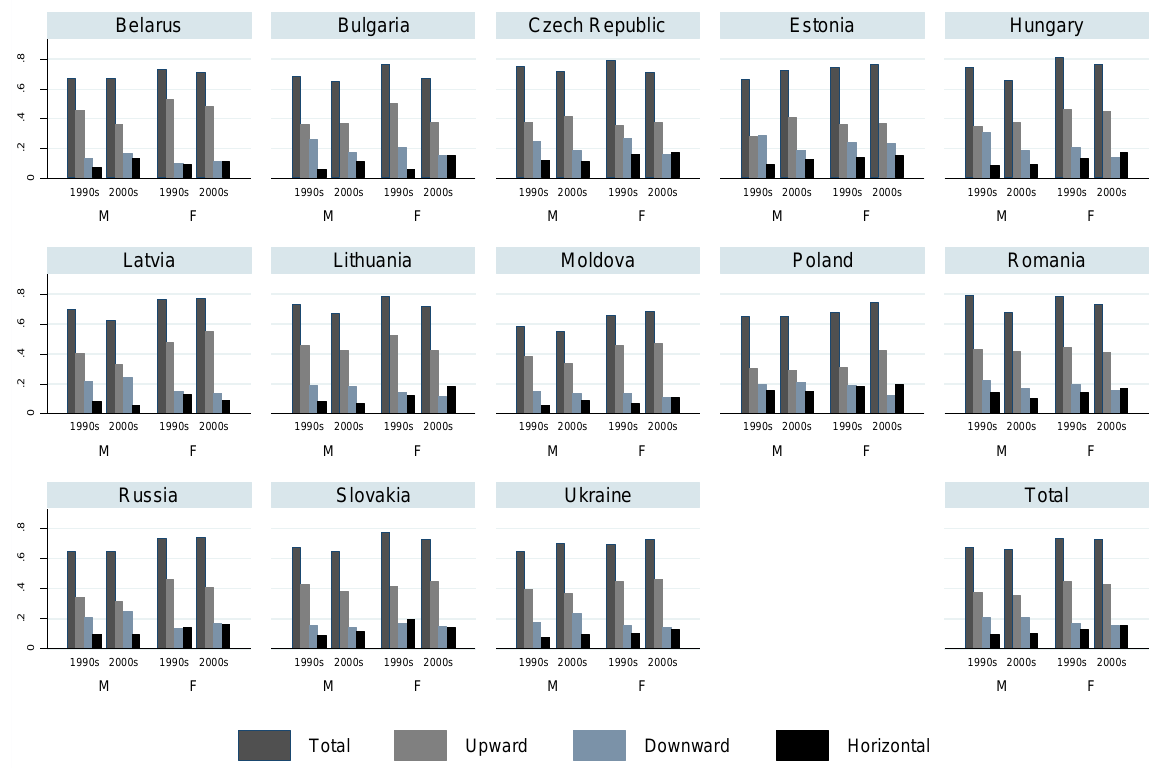
Figure 1: Proportion of men and women in the early 1990s and late 2000s experiencing mobility ("total mobility rate"), upward mobility, downward mobility, and horizontal mobility in each of the 13 countries and in total across the